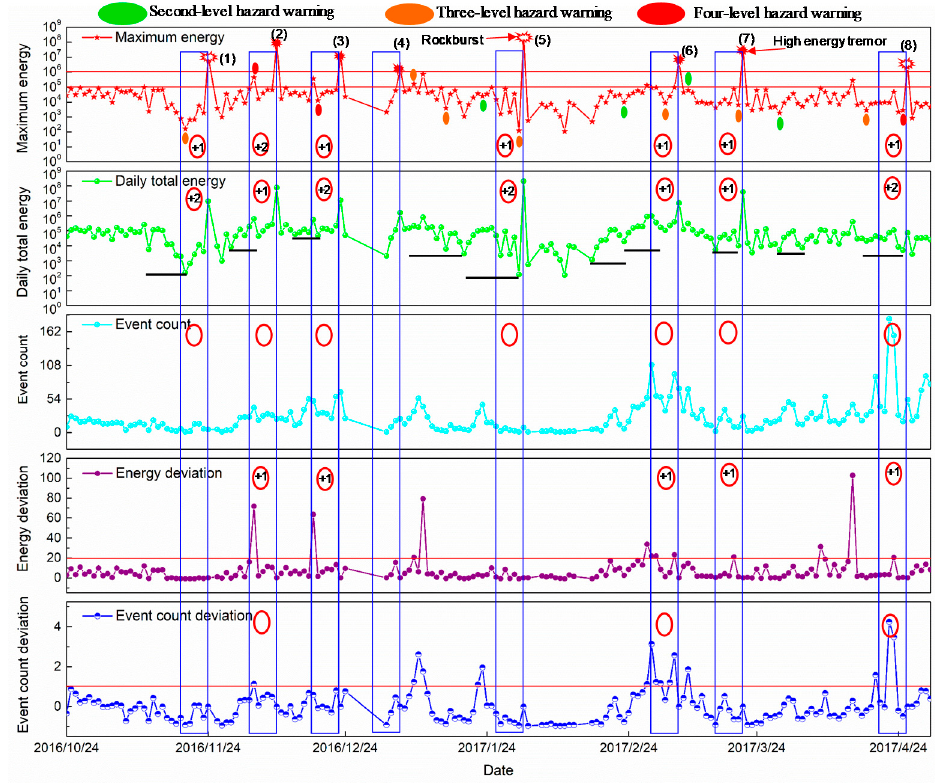
Figure 17. Early warning results of “critical value + trend” early warning method (precursor analysis stage).